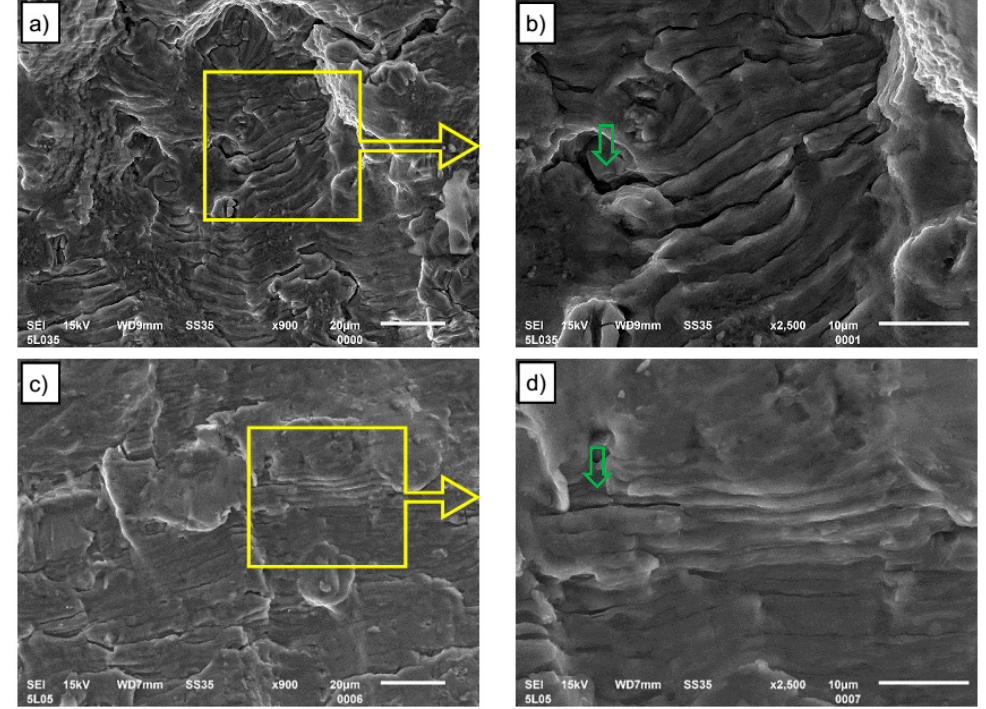
Figure 13. Fatigue crack propagation regions for FSW joints at different strain amplitudes: ( a ) and ( b )— ε ac = 0.35% and ( c ) and ( d )— ε ac = 0.5%.